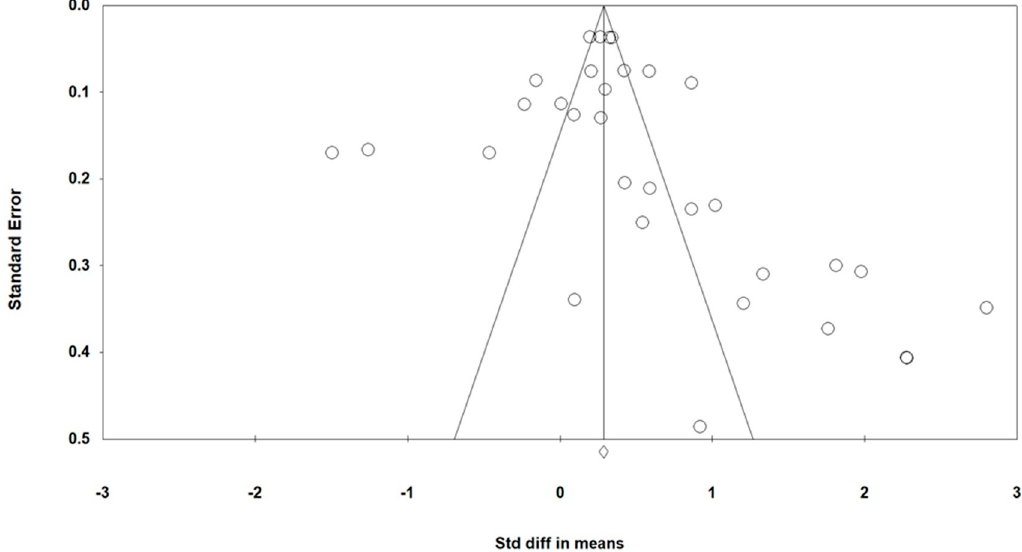
Figure 3. Funnel plot of all 32 effects from treatment and control samples.